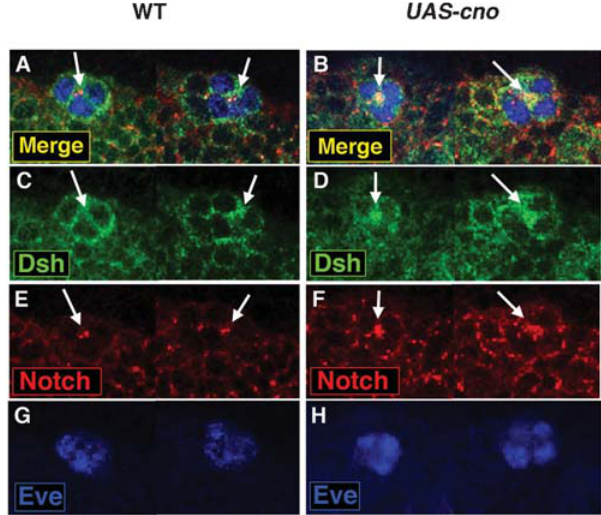
Figure 6. Overexpression of Cno leads to the stabilization of Dsh and N close to the membranes of Eve + interacting cells. The most dorsal part of two hemisegments of stage 11 embryos are shown in all panels (63 6 magnification). Eve marks a dorsal equivalence group in the mesoderm (blue). (A, C, E, G) In wildtype (WT) embryos, Dsh (green) and N (red) colocalize at some regions in Eve + cell clusters (arrows). (B, D, F, H) Cno overexpression ( UAS-cno ) leads to an increase of Dsh and N close to the membranes of Eve + cells